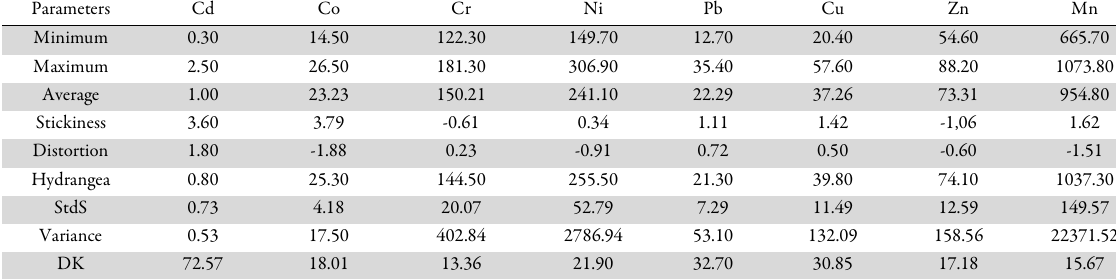
Table 3. The descriptive statistics of heavy metal content of soils (n = 7)